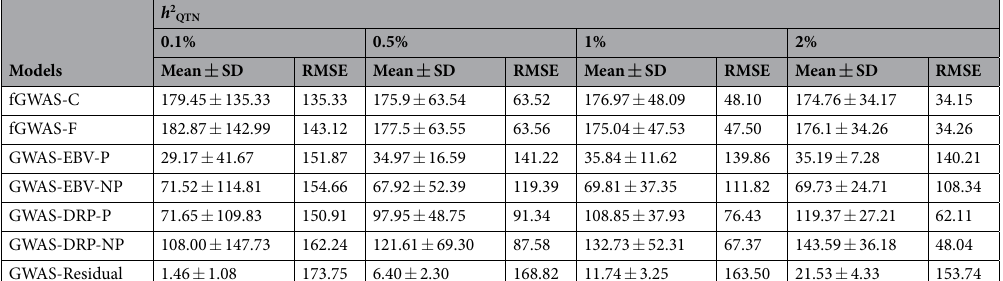
Table 1. Means, standard deviations (SD), and root-mean-square errors (RMSE) of estimated cumulative additive genetic effect of the QTN for different GWAS models with various QTN heritabilities in the simulation